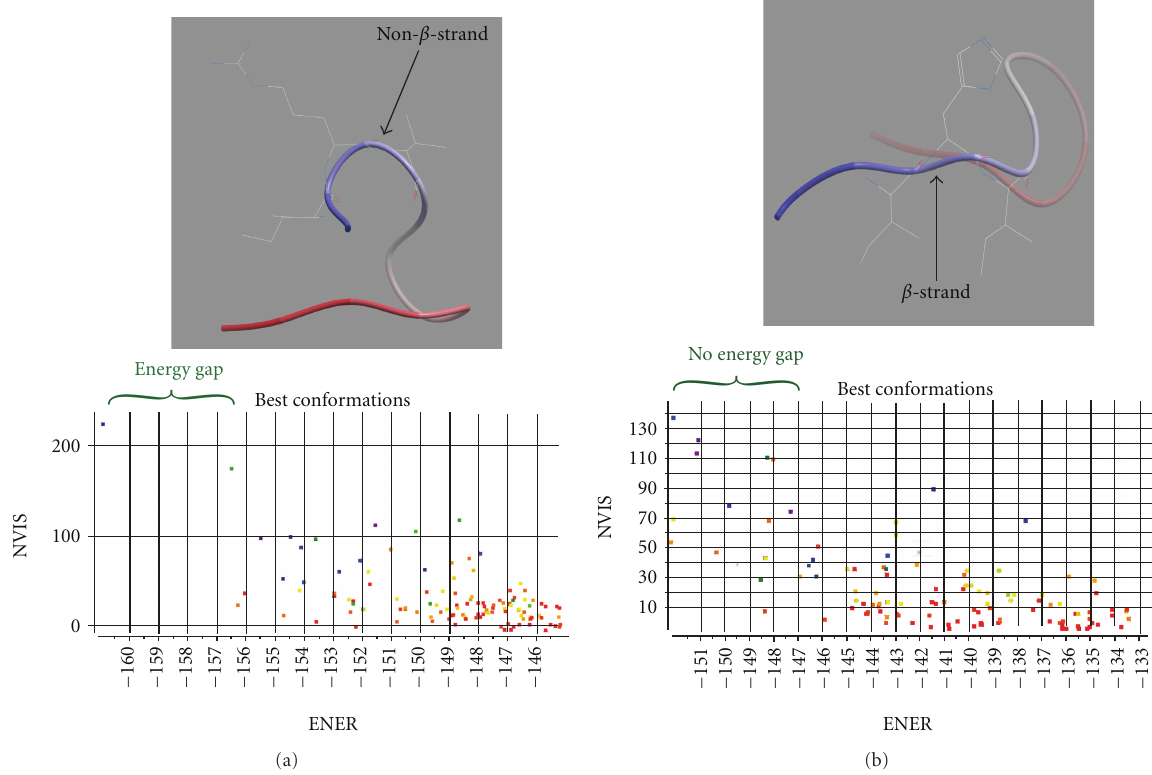
Figure 2: (a) Top: lowest energy conformation of the subtype C V3 loop crown from V3 loop amino acid positions 10 to 22. The structure is shown in ribbon representation colored in a gradient from the N-terminal residue at position 10 (dark blue) to the C-terminal residue at position 22 (colored dark red). The side chain conformations of Ile12, Arg13, and Ile14 are shown in full-atom wire representation. Their backbone curvature and fanned orientation are inconsistent with β -strand secondary structure. Bottom: plot of 180 lowest energy conformations from the folding simulation. x -axis (ENER): energy score ranging from lowest at the left to higher at the right. y -axis (NVIS): number of visits by the simulation to the indicated conformation. For example, the lowest energy conformation was found again and again by the search over 150 times. The presence of a 4kcal simulation energy unit gap in the subtype C simulation indicates a rigid structure as a 4kcal energy barrier prevents exit from the lowest energy conformation most of the time on the biological time scale. (b) Top: lowest energy conformation of the subtype B V3 loop crown from positions 10–22 depicted as in A. The extended linear conformation of Ile12, Arg13, and Ile14 with alternating directions for the side chains is typical of canonical β -strand structure. Bottom: plot of 180 lowest energy conformations from the folding simulation as in A. Many conformations are present near the lowest energy conformation in this subtype B simulation predicting a flexible structure that flickers between ∼ 10 conformations all the time (is flexible) on the biological